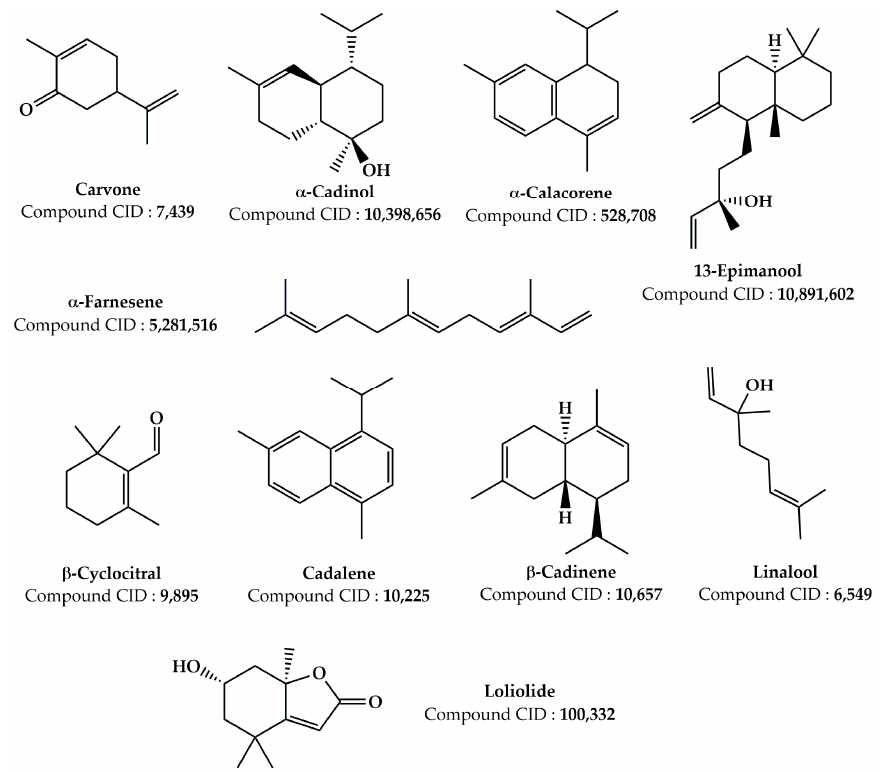
Figure 4. Chemical structures of the terpene compounds detected in the Z. lotus extracts.